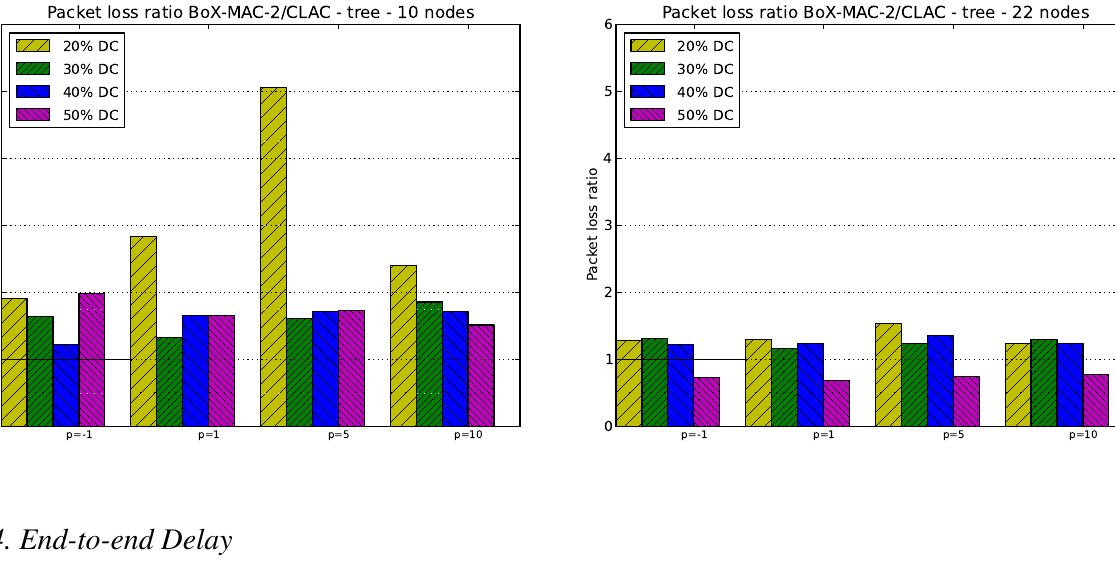
Figure 12. Packet loss ratio for 10- and 22-node tree